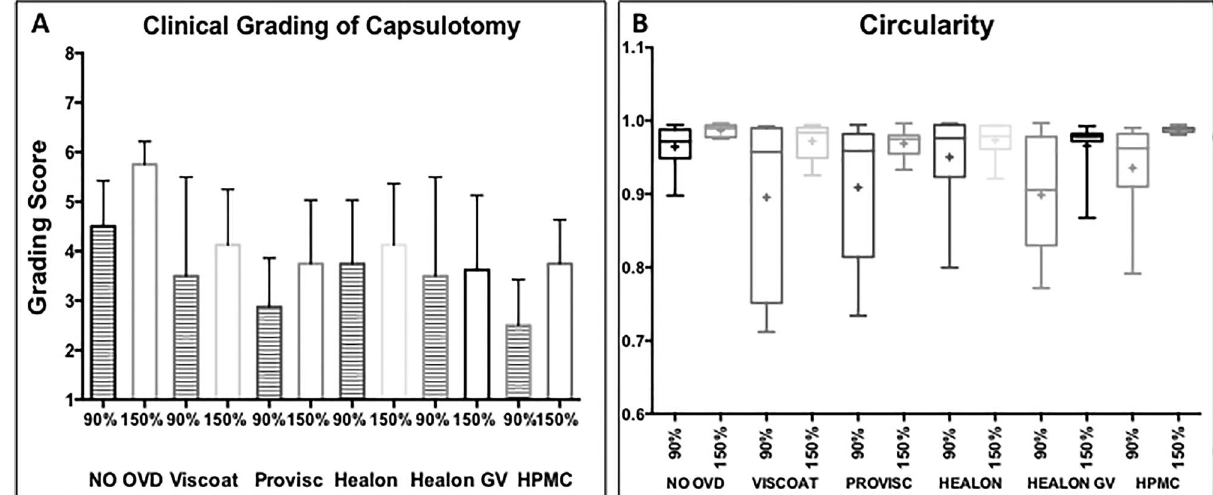
Figure 1. Comparison of the clinical grading of laser-capsulotomy and circularity in sub-groups with 90% and 150% energy settings. ( A ) The striped and plain bar charts represent the grading score, with 90% and 150% energy settings, respectively. ( B ) The box and whisker plots show variability in the plotted data for circularity. The ‘mean’ is represented by a ‘+’ in the box plots. The box extends from the 25th to 75th percentiles. ( A , B ) Increasing energy setting from 90 to 150% improved the grading score of laser-capsulotomy, and showed a better circularity, respectively, across the